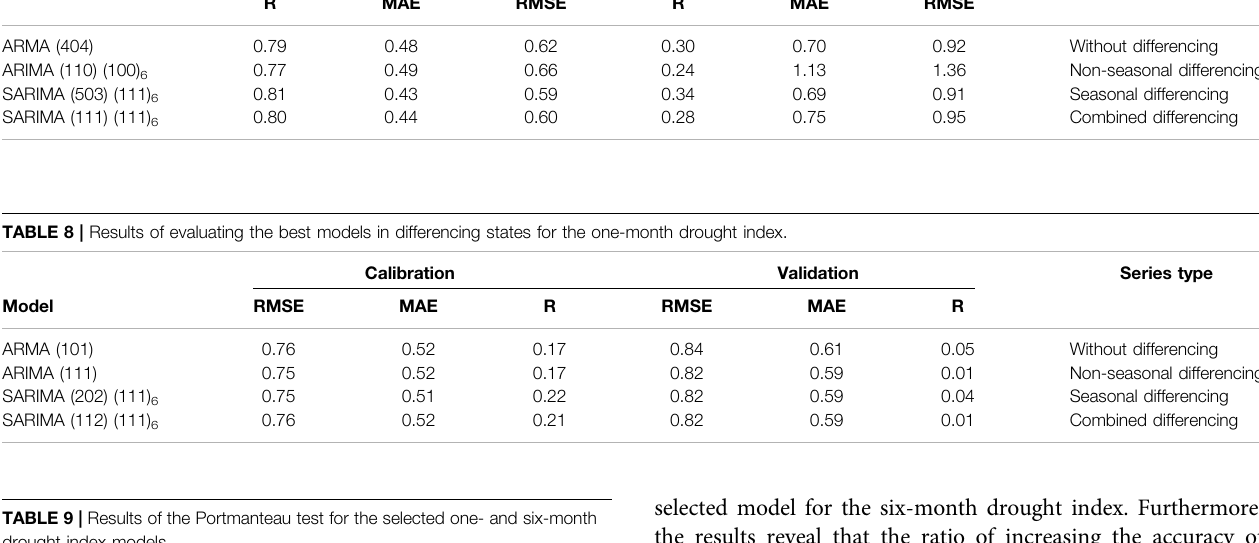
TABLE 9 | Results of the Portmanteau test for the selected one- and six-month drought index models.